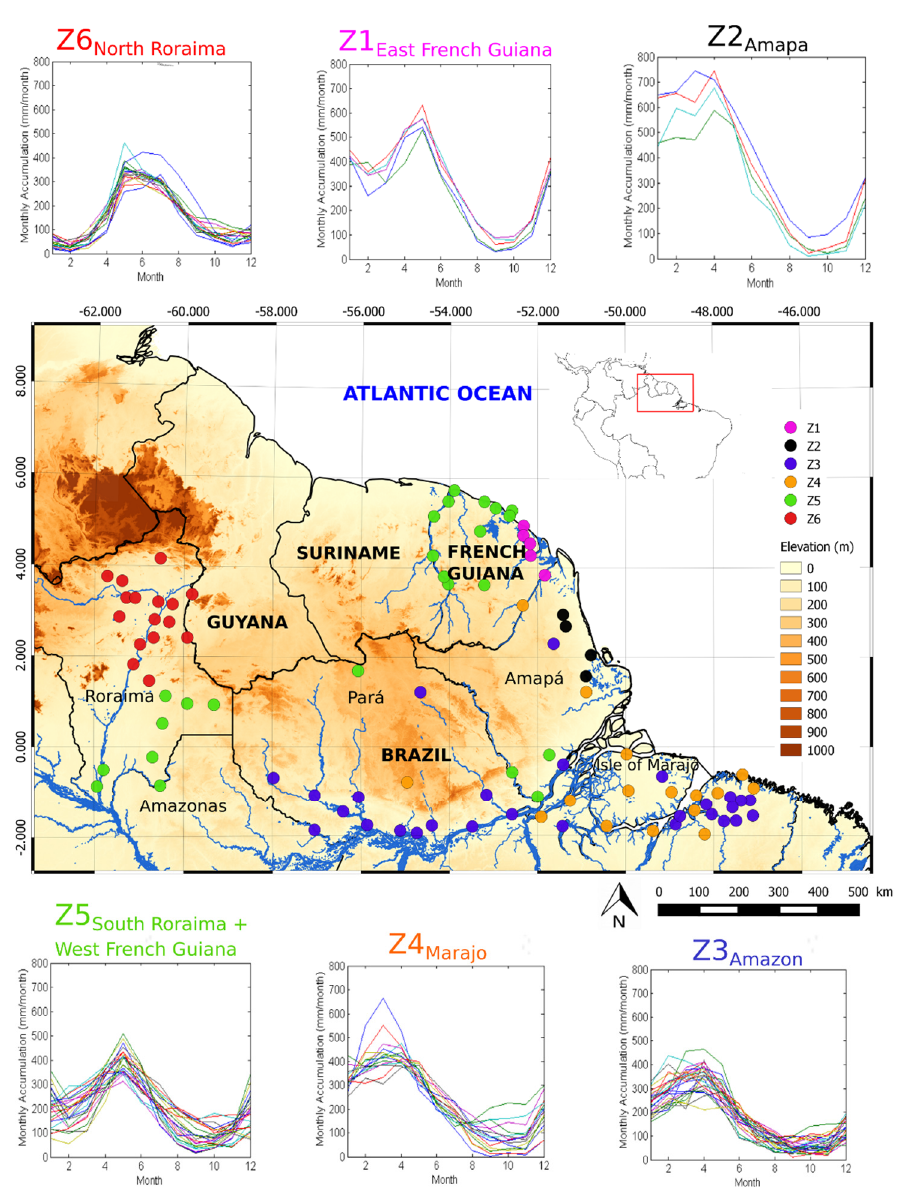
Figure 1. An elevation map of the Guiana Shield. The SRTM30 (Shuttle Radar Topography Mission) is available at http://www.diva-gis.org/gdata. The dots represent the in situ gauges available in French Guiana and northern Brazil. The six different colors stand for the six hydro-climatic regimes identified according to ascending hierarchical clustering. For each of the areas, the annual precipitation (mm/month) is indicated. The six areas are: Z1 East French Guiana ; Z2 Amapá ; Z3 Amazon ; Z4 Marajó ; Z5 South Roraima+West French Guiana ; and Z6 North Roraima .